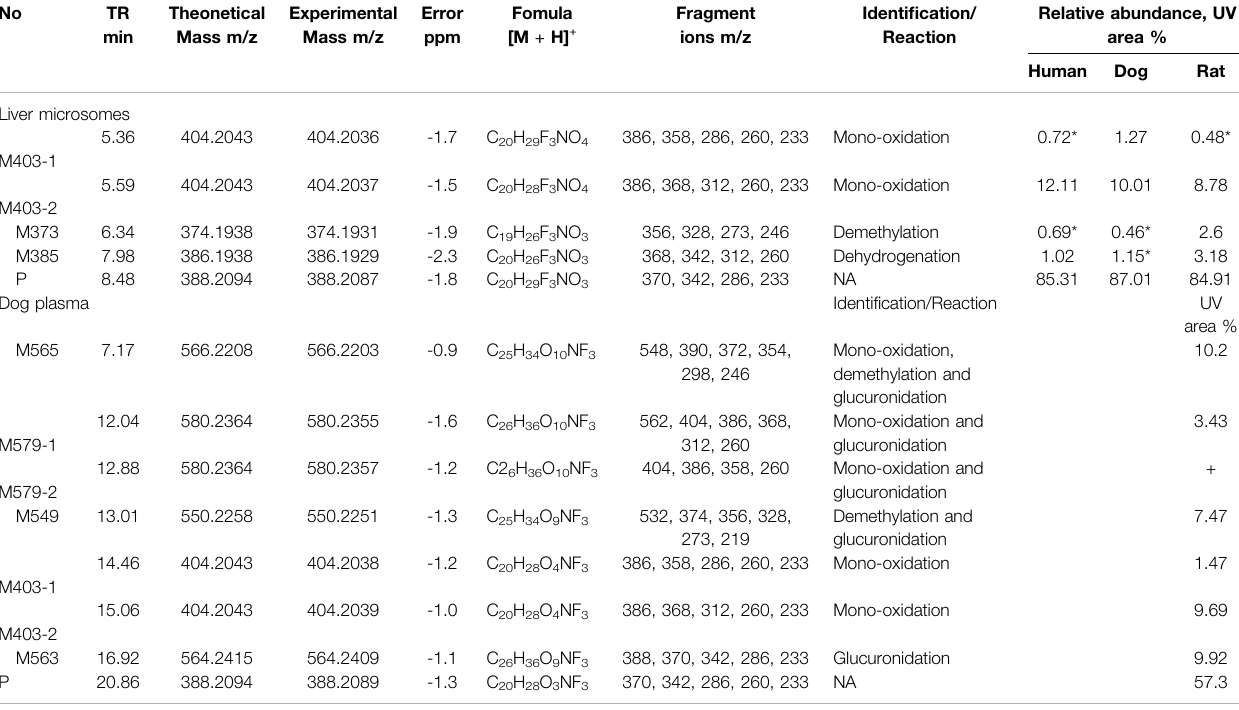
TABLE 3 | Summary of the metabolites of (+)-9-tri fl uoroethoxy- α -dihydrotetrabenazine [(+)-13e] detected in human, dog and rat liver microsomes and in dog plasma using the UPLC-Q Exactive ™ Orbitrap HRMS. No TR Theonetical min Mass